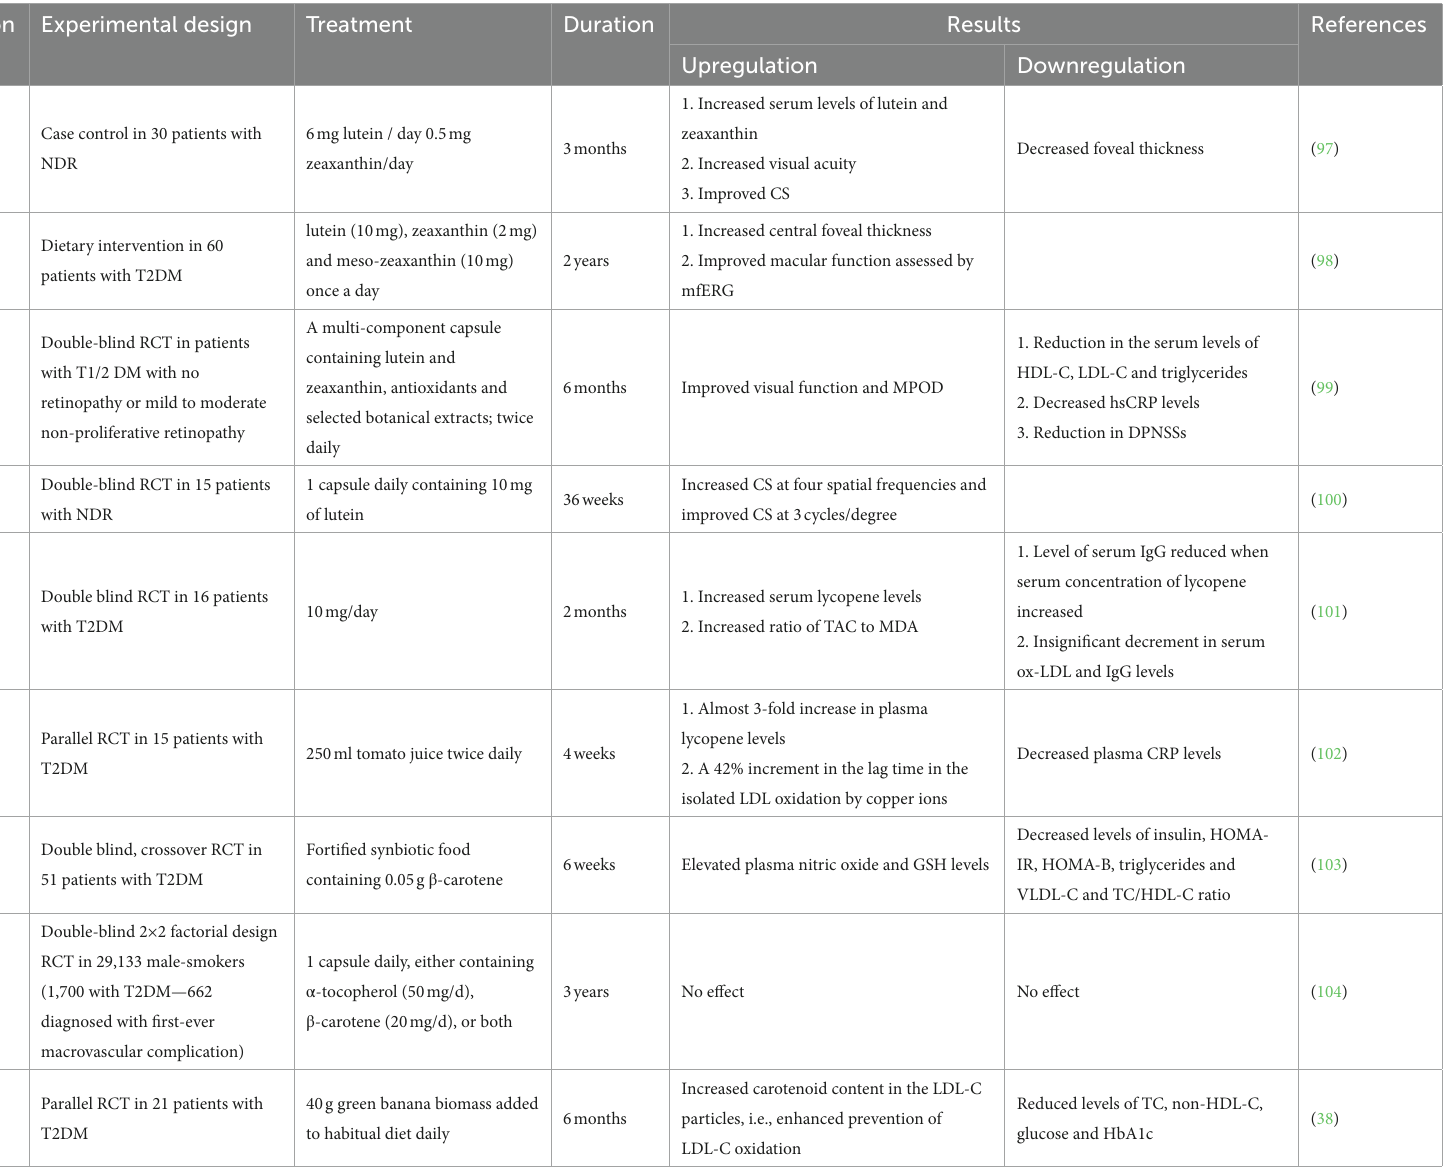
TABLE 5 Protective effects of carotenoids against diabetic complications—clinical evidence. Carotenoid